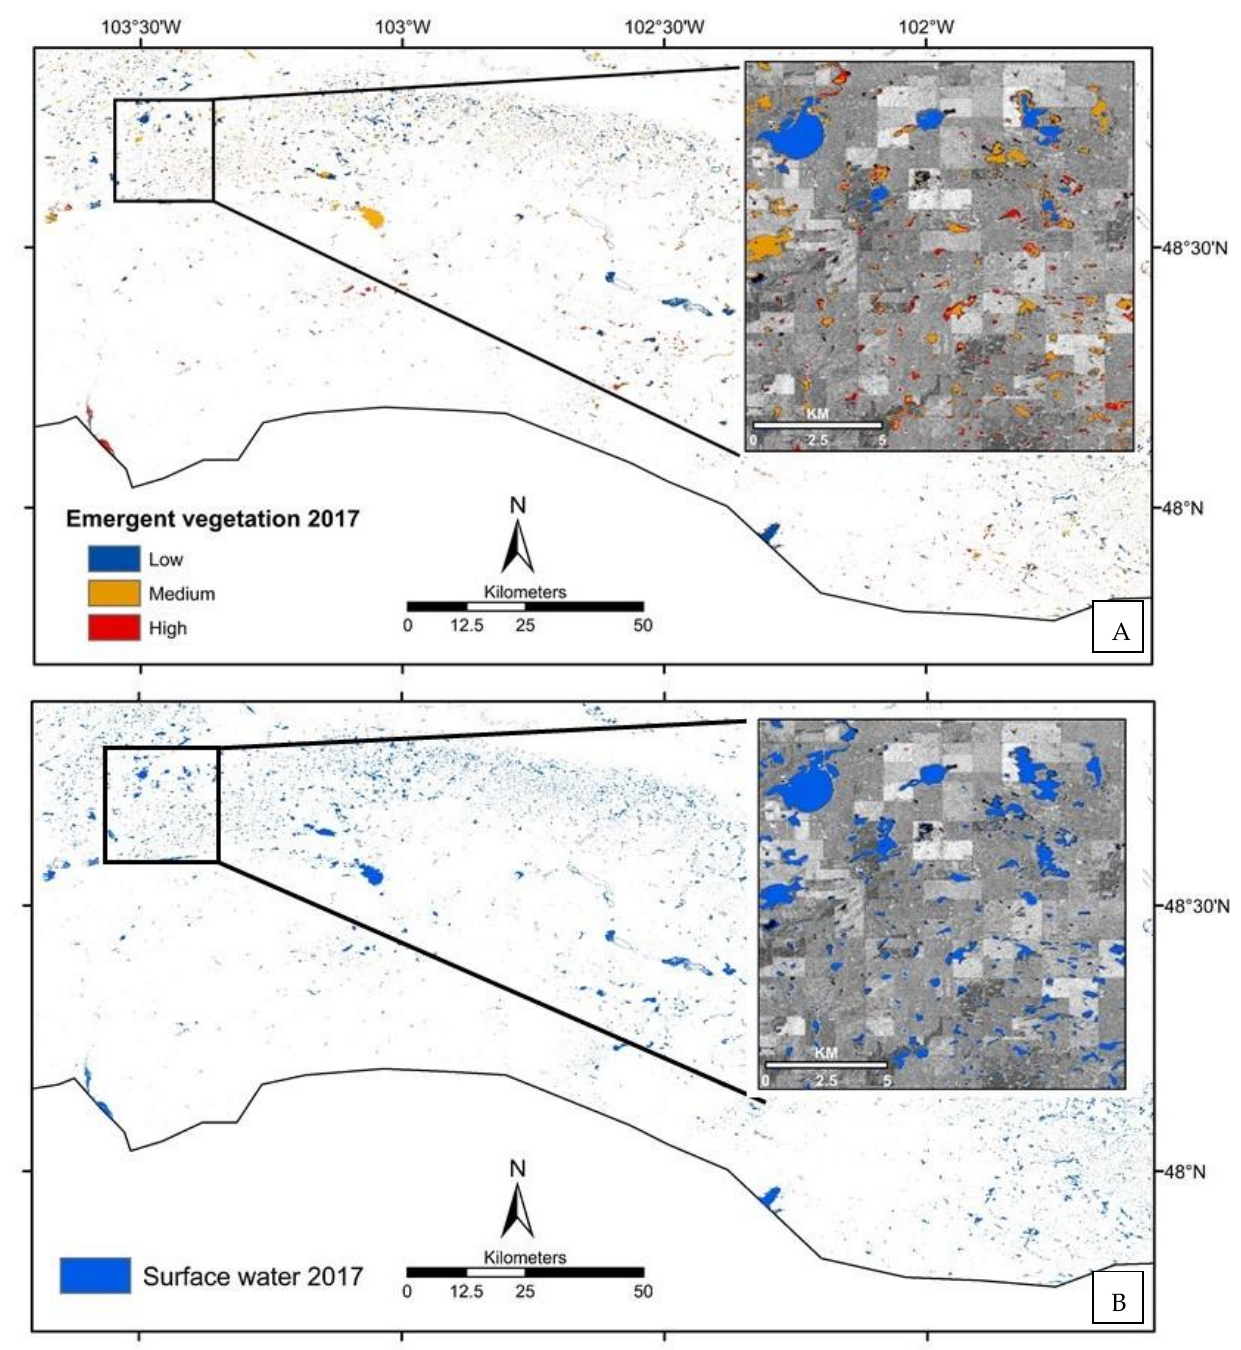
Figure 7. Spatial distribution of emergent vegetation in inundated wetlands ( A ), spatial distribution of surface water ( B ) in August 2017.